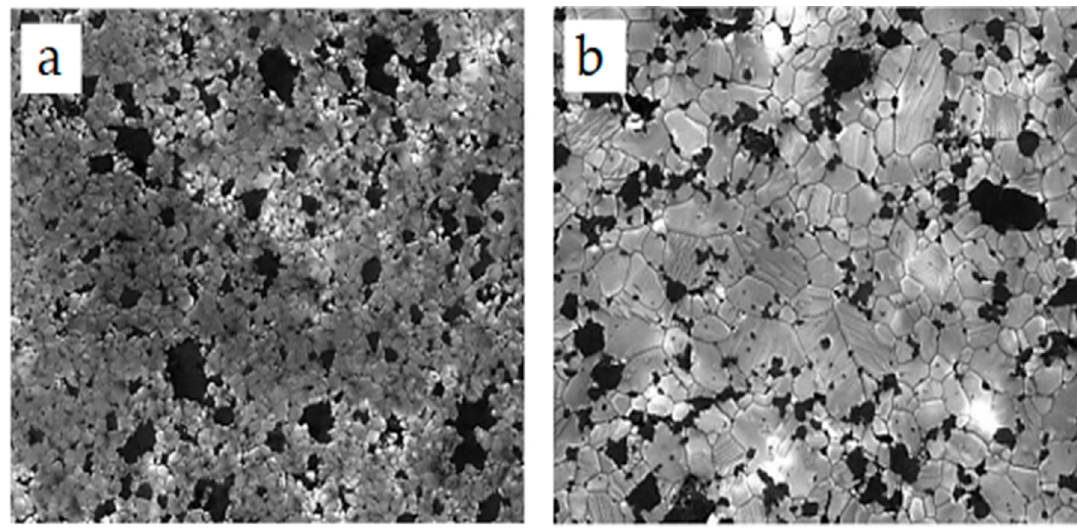
Figure 13. FE–SEM of Al 2 O 3 –SiC nanocomposites sintered by SPS: ( a ) 1400 °C; ( b ) 1550 °C at 2 µm magnification. Reproduced with permission from [86]. Copyright Elsevier,